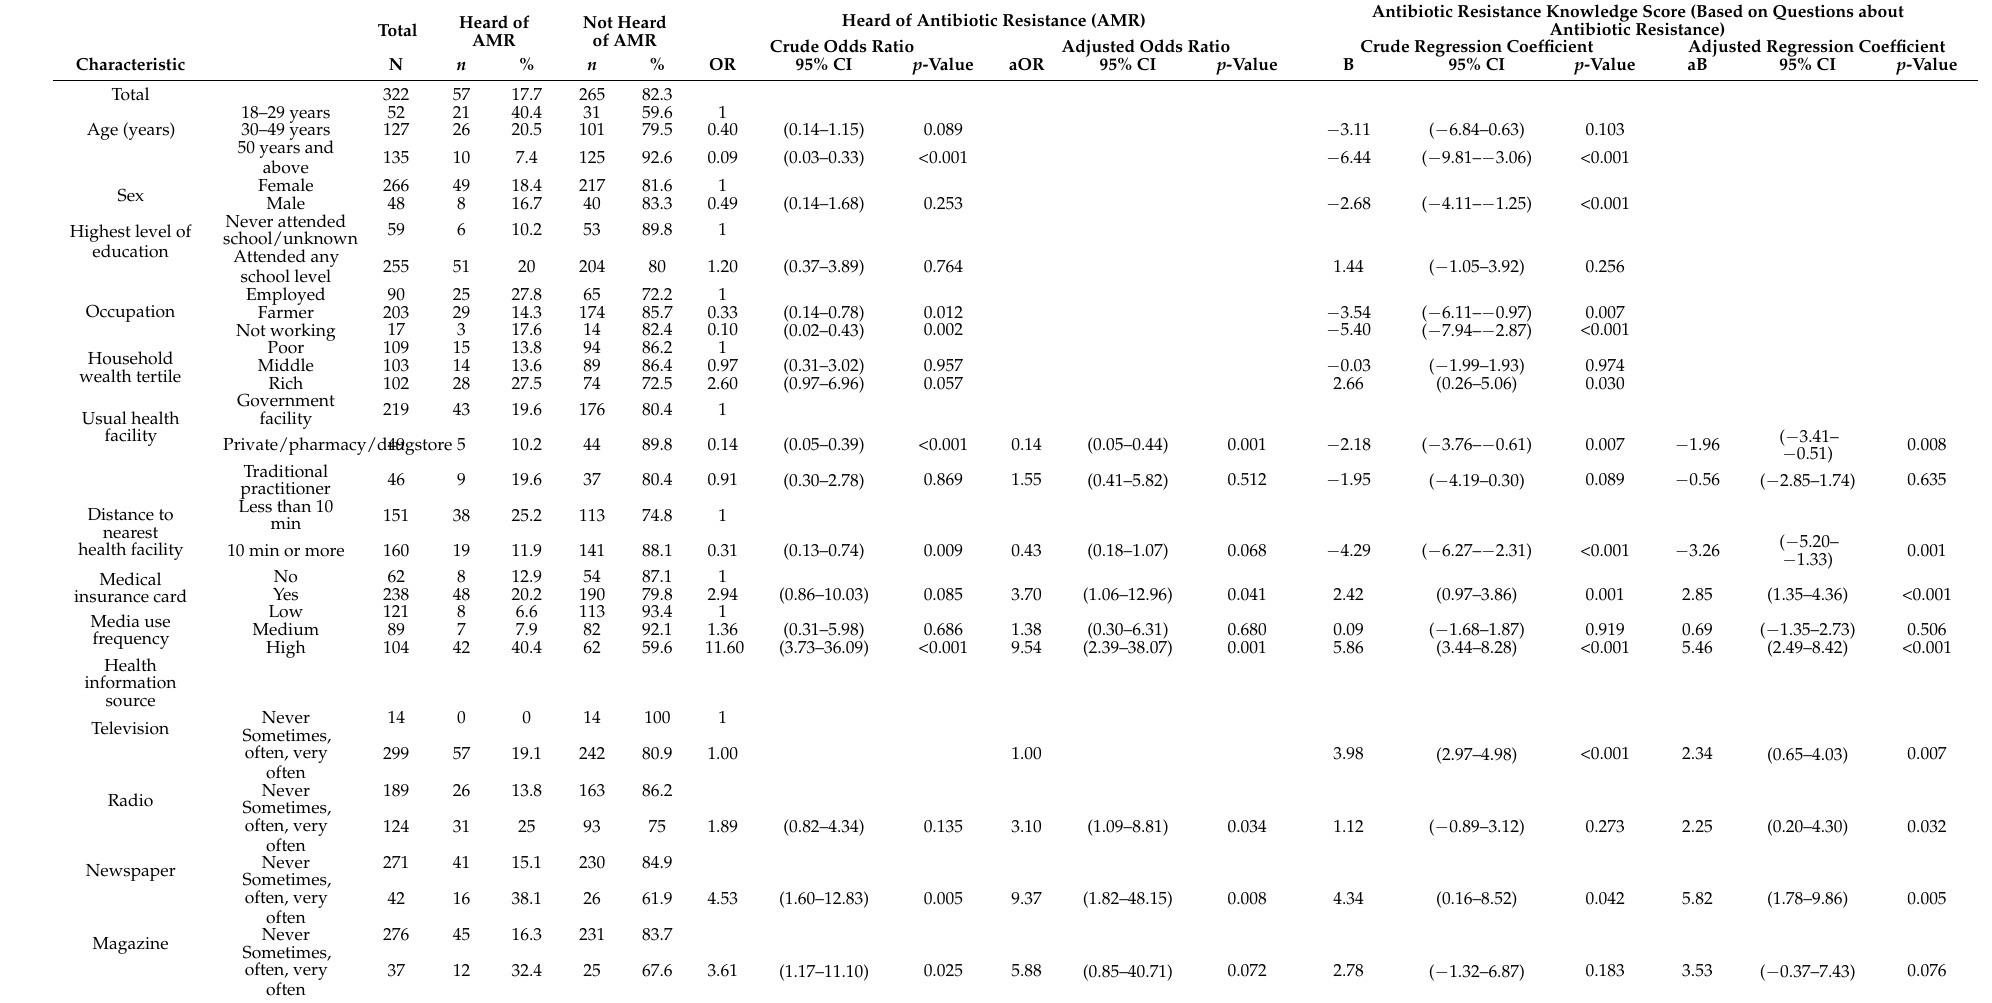
Table 3. Univariable and multivariable regression modelling of antibiotic resistance